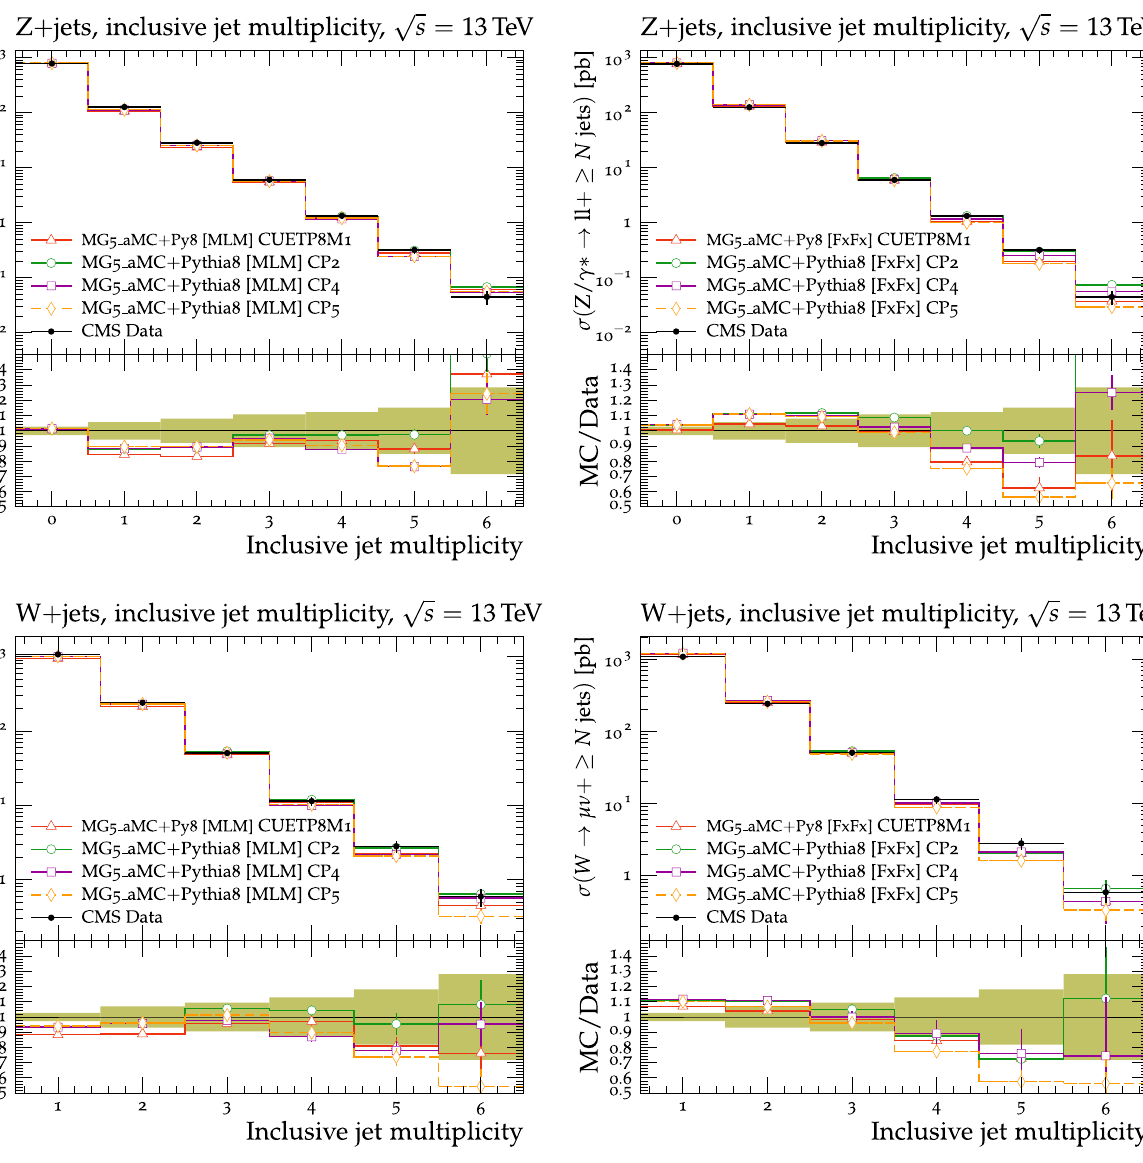
Fig. 22 Comparison with the measurement [71,72] of the inclusive jet the shaded band indicates the total experimental uncertainty in the data. Vertical lines drawn on the data points refer to the total uncertainty in multiplicity in Z + jets (upper) and W + jets (lower) events predicted by mg5 _a mc + pythia 8 with k the data. Vertical lines drawn on the MC points refer to the statistical T –MLM merging (left) and FxFx merging uncertainty in the predictions. Horizontal bars indicate the associated (right) for the different tunes. Tunes CP1 and CP3 are not shown in the bin plotbutpresentasimilarbehaviouras,respectively,tunesCP2andCP4. The ratios of simulations to the data (MC/Data) are also shown, where